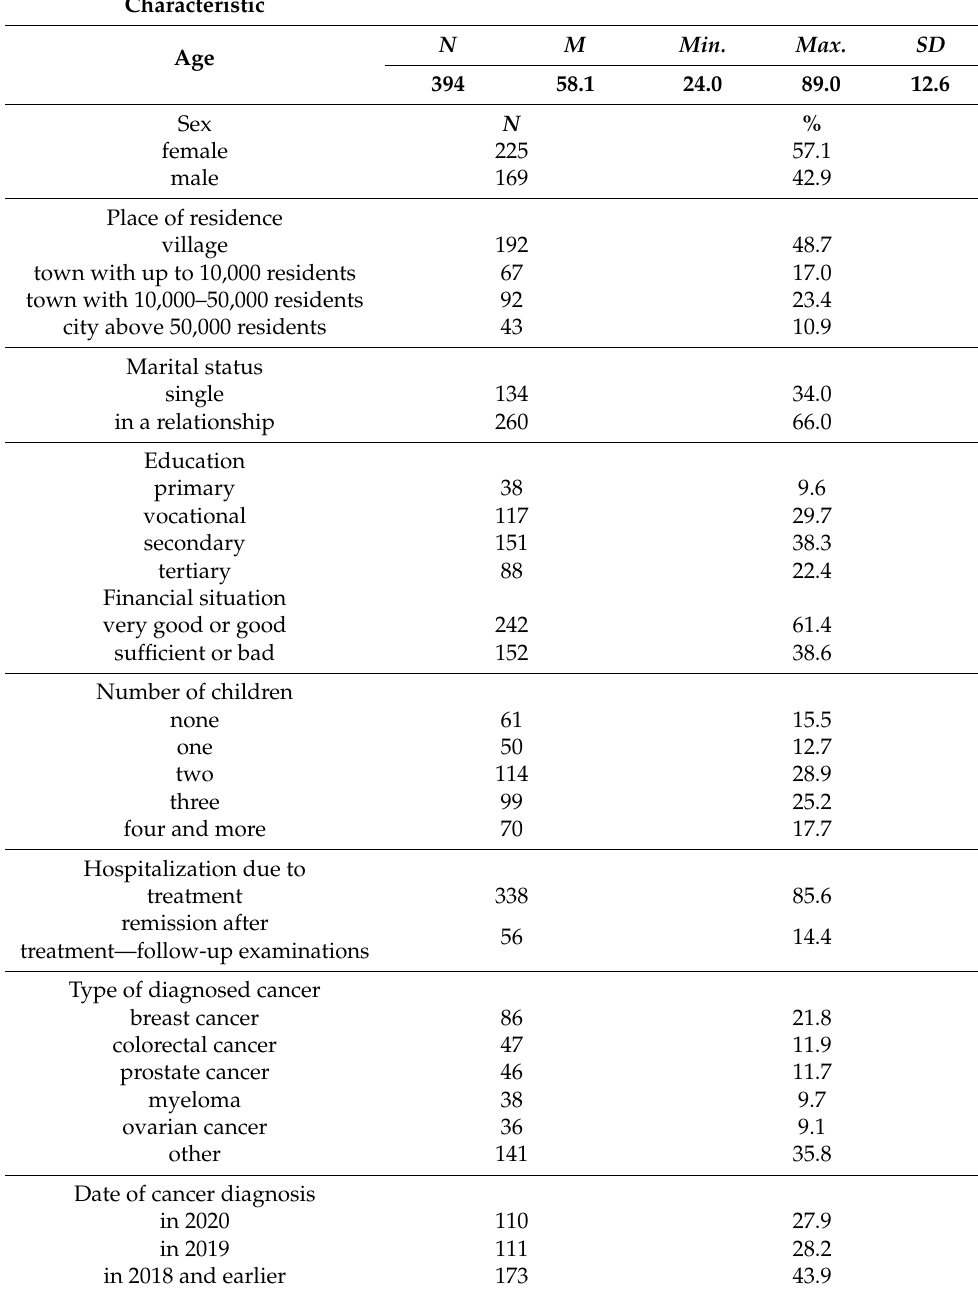
Table 1. Patient characteristics in terms of sociodemographic and medical (clinical)